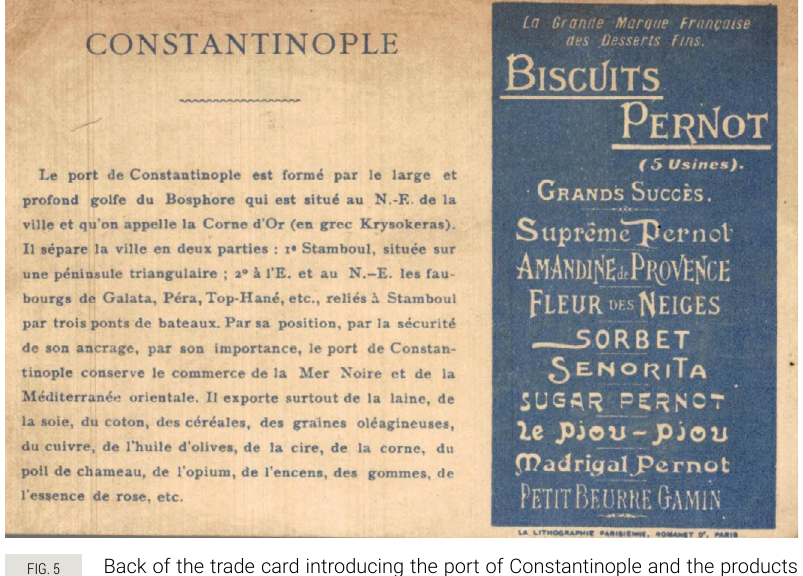
FIG. 5 Back of the trade card introducing the port of Constantinople and the products being exported. Some of the raw products listed are: Wool, silk, cotton, cereals, oilseeds, copper, olive oil, wax, camel hair, opium, gum, rose essence. Author’s collection.